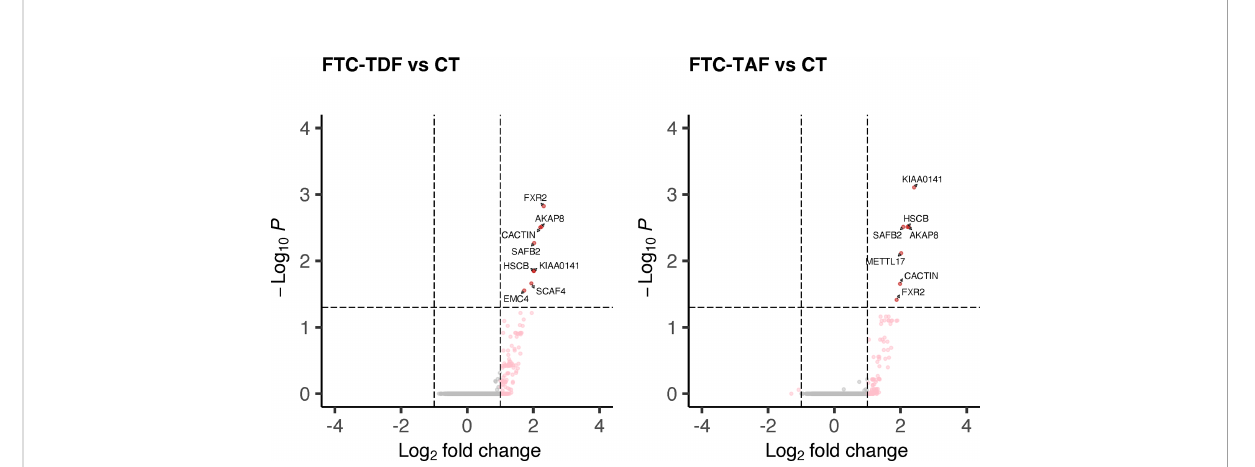
FIGURE 4 DEGs in merged PrEP-treatment arms as compared to control arm. All specimens from South Africa and Uganda were merged and strati fi ed by administered PrEP drug. The merged arms were then compared to the control group and the statistically signi fi cant DEGs shown according to the administered PrEP